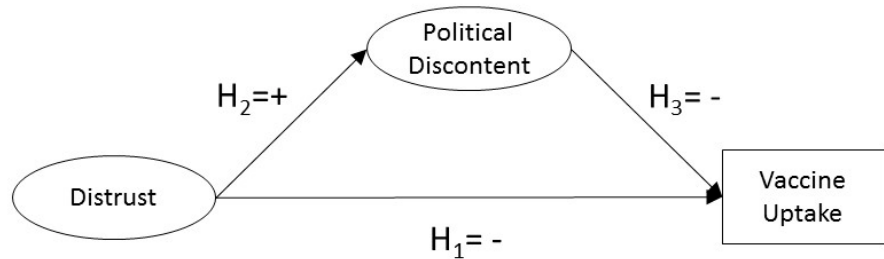
Figure 1. Conceptual model and hypotheses.